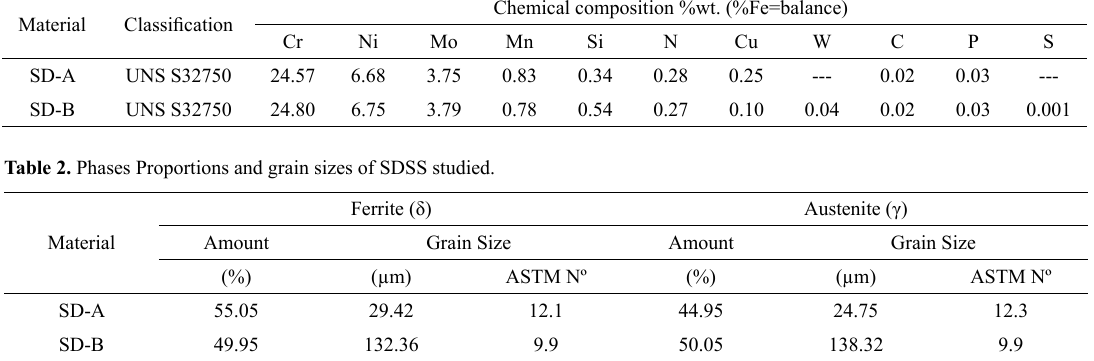
Table 1. Chemical composition of the SDSS analysed. Material Classification